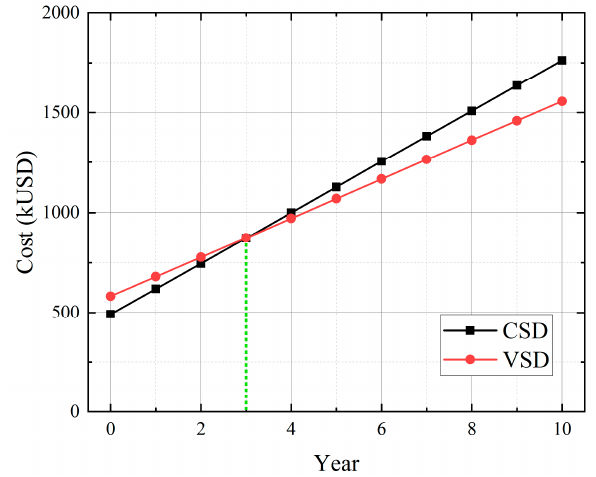
Figure 11. Recovery period of the initial investment in